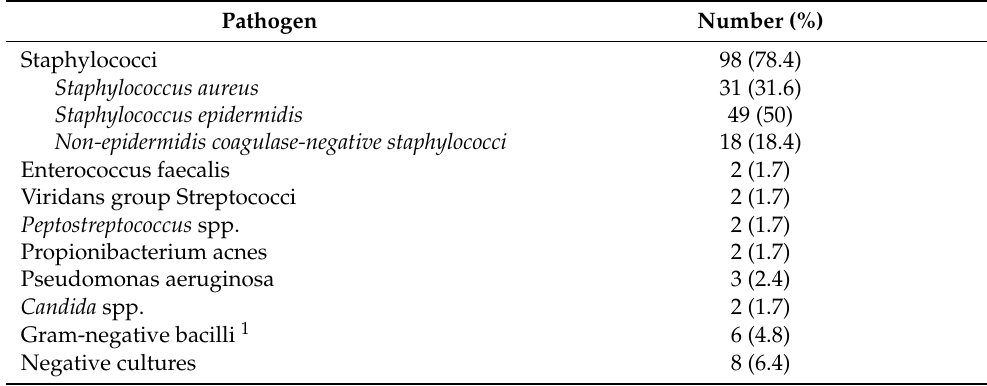
Table 2. Microbiological isolates of CIED-related IE